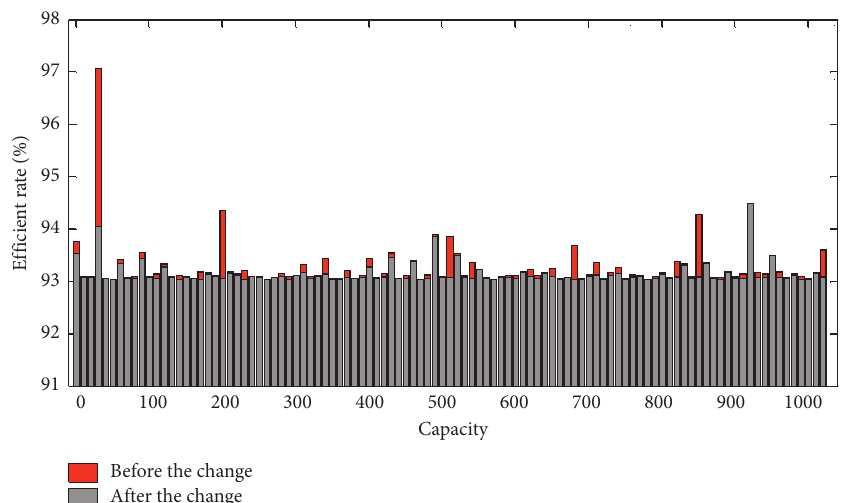
Figure 6: Effectiveness of the multidimensional learning space index under different capacities.